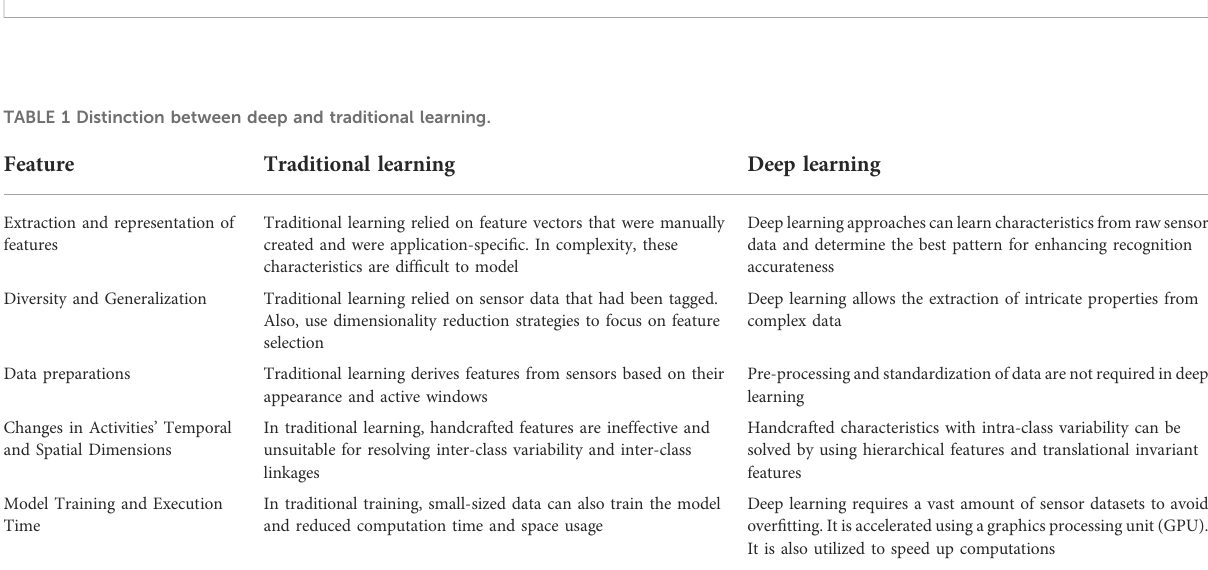
FIGURE 7 (cid:129) Long short-term memory. The input port, also known as the gate, controls new data fl ow into the memory. (cid:129) The third port must regulate the information stored as output. irrelevant/unnecessary information.